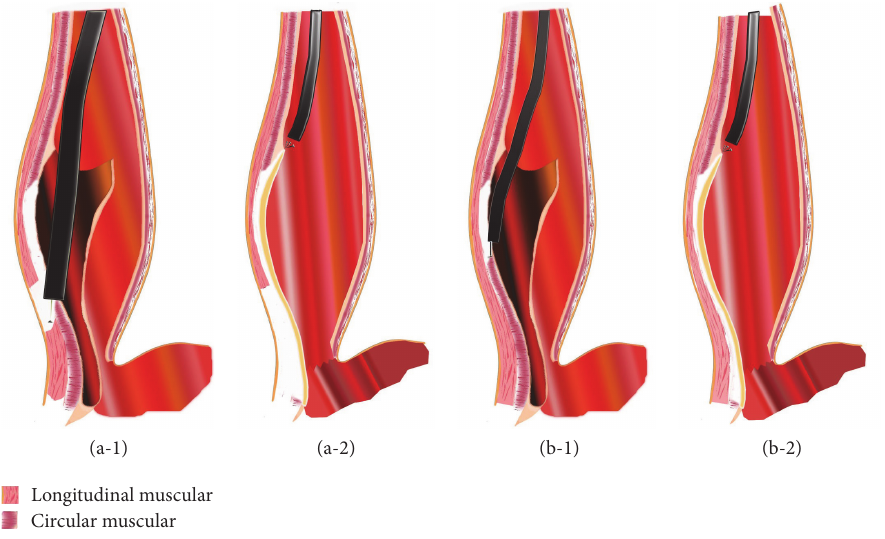
Figure 2: (a-1) The myotomy was begun at about 2 cm distal to the mucosal entry. In partial full-thickness myotomy, not only the circular muscle layer but also the longitudinal muscle layer was cut at 2 cm above the EGJ. (a-2) Distal of full-thickness myotomy was extended to the fundus of the stomach. Incision was closed by endoscopic metallic clips. (b-1) The myotomy was begun at about 2 cm distal to the mucosal entry in partial full-thickness myotomy. In circular muscle myotomy, only circular muscle layer was resected and the longitudinal muscle layer was carefully protected. (b-2) Distal of circular muscle myotomy was extended to the fundus of the stomach. Incision was closed by endoscopic metallic